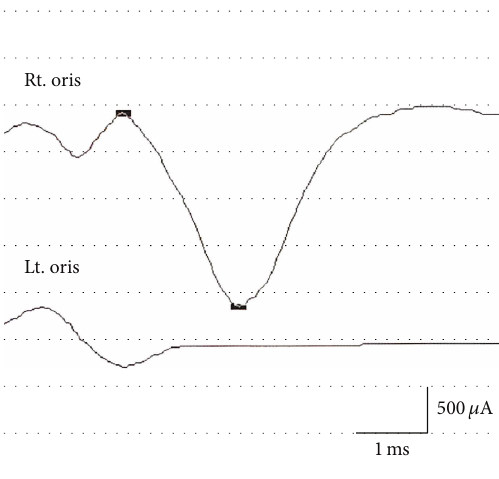
Figure 1: An electroneurograph recorded from the orbicularis oris musclesonthetenthdayofillnessshowingseveredenervationofthe left facial nerve. Supramaximal stimulation was provided through bipolar surface electrodes placed with the anode just outside the stylomastoid foramen and the cathode in front of the ear lobe.